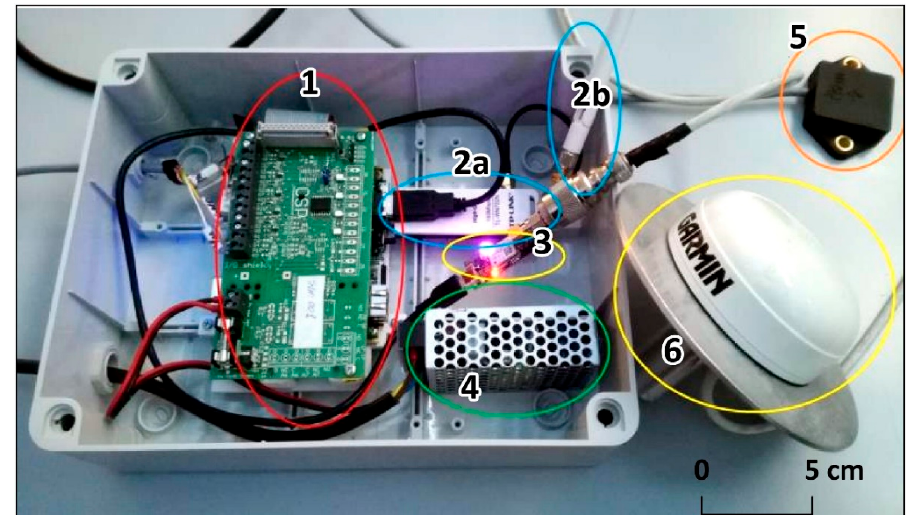
Figure 6. The prototypal multisensor box and the Garmin Antenna. 1 = Micro PC mainboard, 2a = Dongle Wi-fi and relative antenna (2b), 3 = GNSS mass-market uBlox EVK8T Receivers, 4 = Power supply, 5 = Tri-axial accelerometer + temperature sensor, 6 = Garmin antenna. Table 2. Madonna del Sasso site. The unit cost of instrumentations and the estimate installation cost.